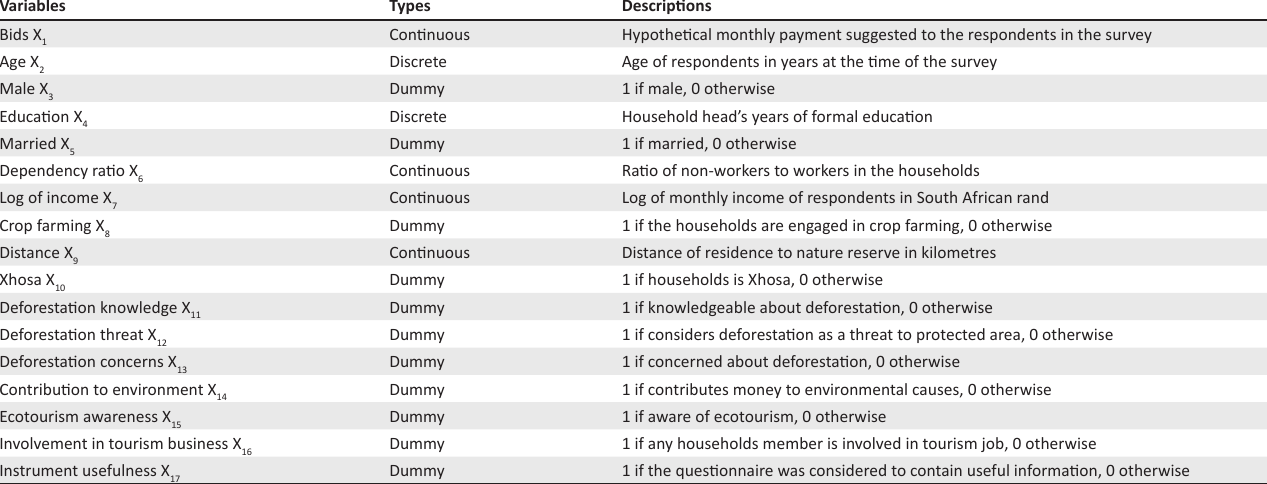
TABLE 1: A priori expectations of the determinants of willingness to pay for community-based ecotourism. Variables